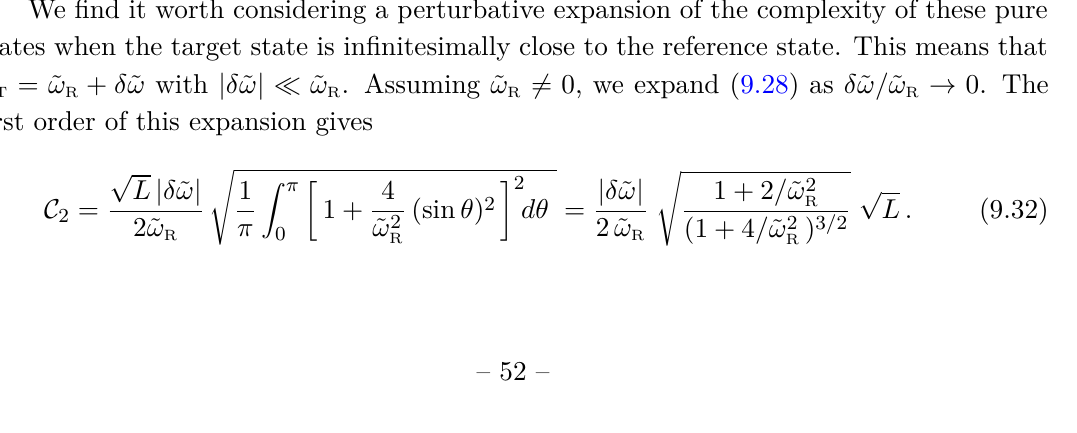
and as function of ω . The data points come from (9.22). The R T = ˜ ω + δ ˜ ω T R